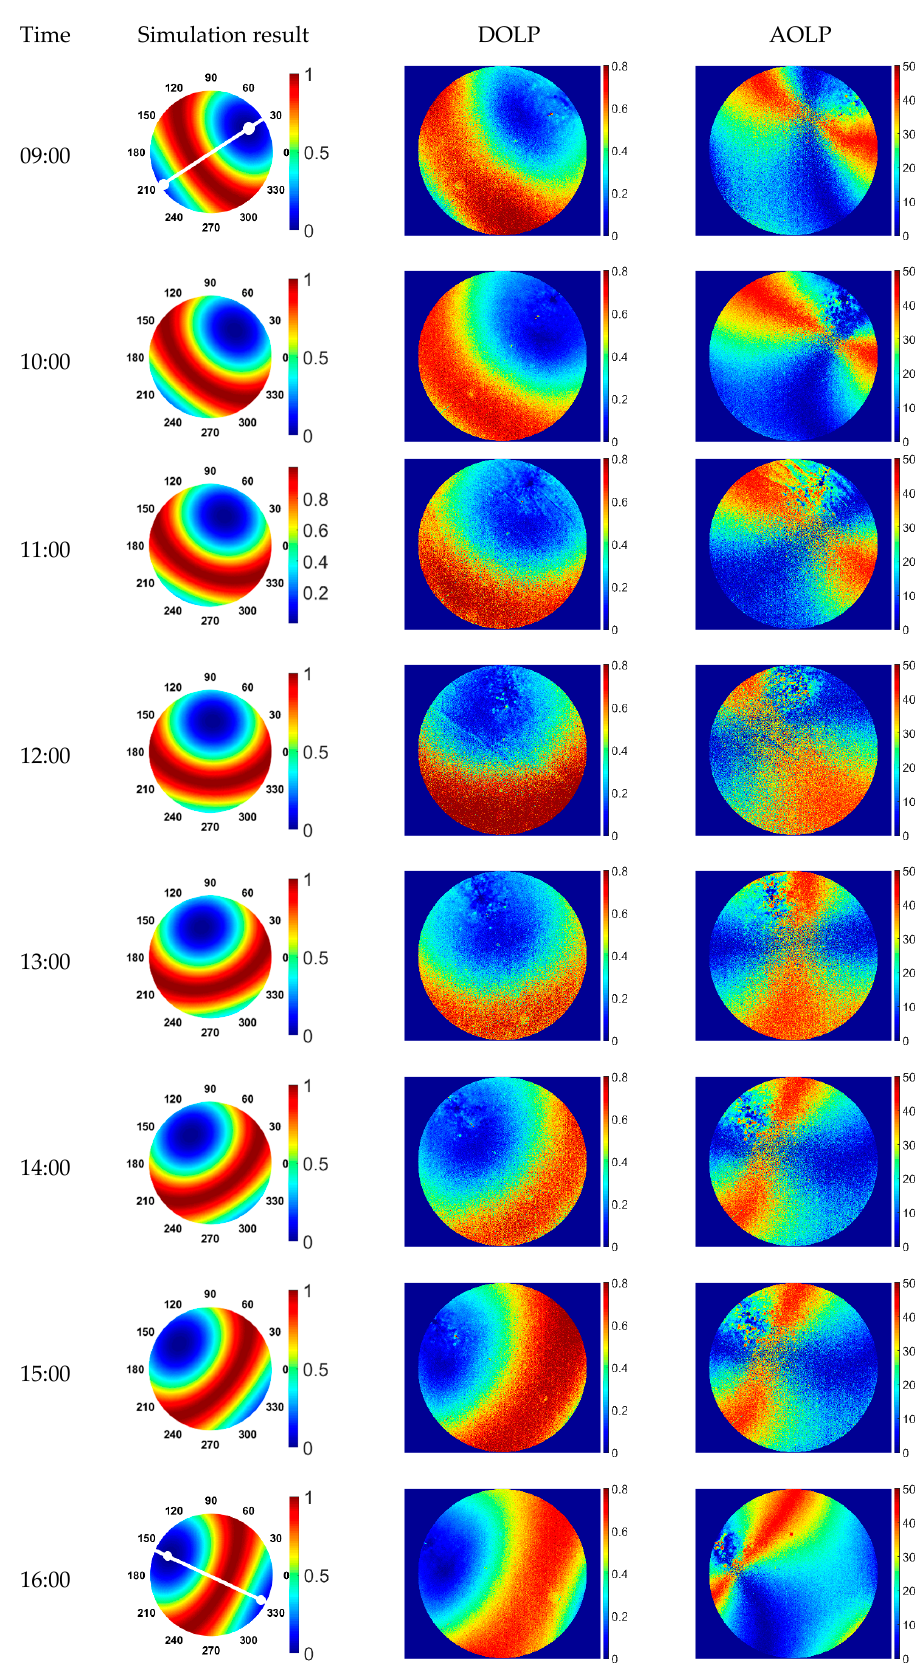
Figure 4. Daily variation in the DOLP and AOLP of skylight (March 13, 2019). When the solar altitude angle is low, such as at 9:00 a.m. and 16:00 p.m., the two polarization neutral points at the sun point and anti-sun point is more obvious. The degree of polarization of the sun’s incident direction is the smallest, which is the neutral point of the atmosphere. The degree of polarization of the center to the surrounding area gradually increases, and the degree of polarization perpendicular to the sun’s incident direction reaches the maximum and then begins to decrease. This is because there is a neutral point near the sun, and there is also a neutral point on the anti-sun side, that is, the Babinet point and Arago point, respectively. The interaction of the two points results in a double aper- ture effect.